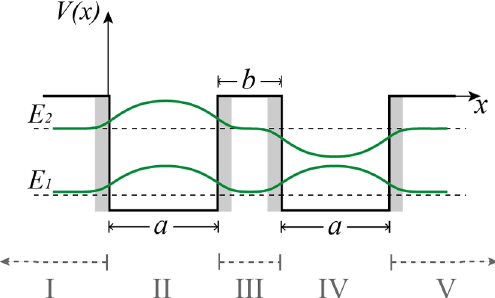
FIG. 10. A plot of the double finite square well potential. The regions were indicated by Cam, and were not present in the initial diagram. Sketches of the ground state and first excited state wave functions (the answer to the protocol question) are shown on top of the